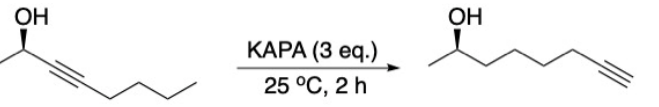
Figure 1. The structure of APA, KAPA and